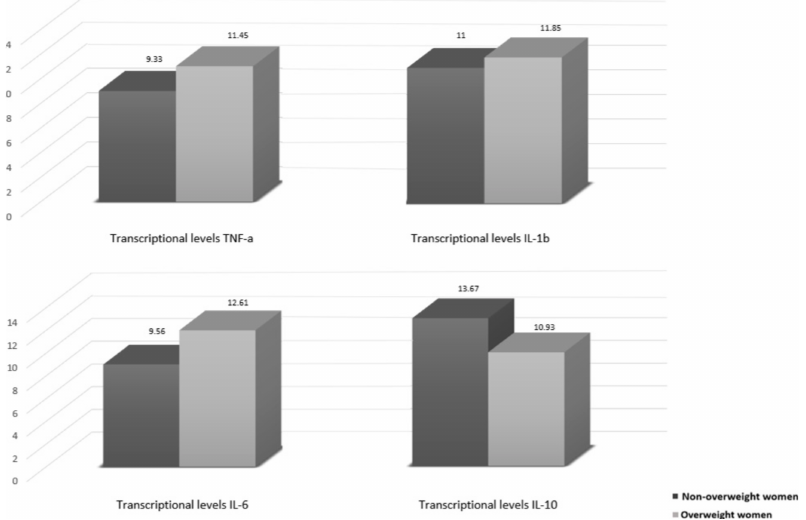
Figure 4. Association of overweight with inflammatory markers in T2. IL-1 β , Interleukin-1 β ( n = 22); IL-6, Interleukin-6 ( n = 22); IL-10, Interleukin-10 ( n = 23); TNF- α , Tumor Necrosis Factor α ( n = 20). Dark gray shows means for non-overweight women and light gray shows means for overweight women. Mann Whitney